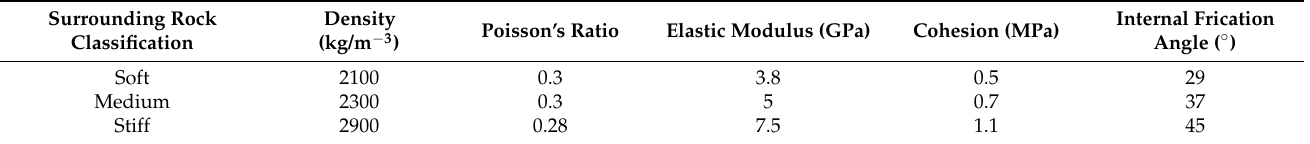
Table 5. Physical and mechanical properties of the surrounding rock mass in the fault fracture